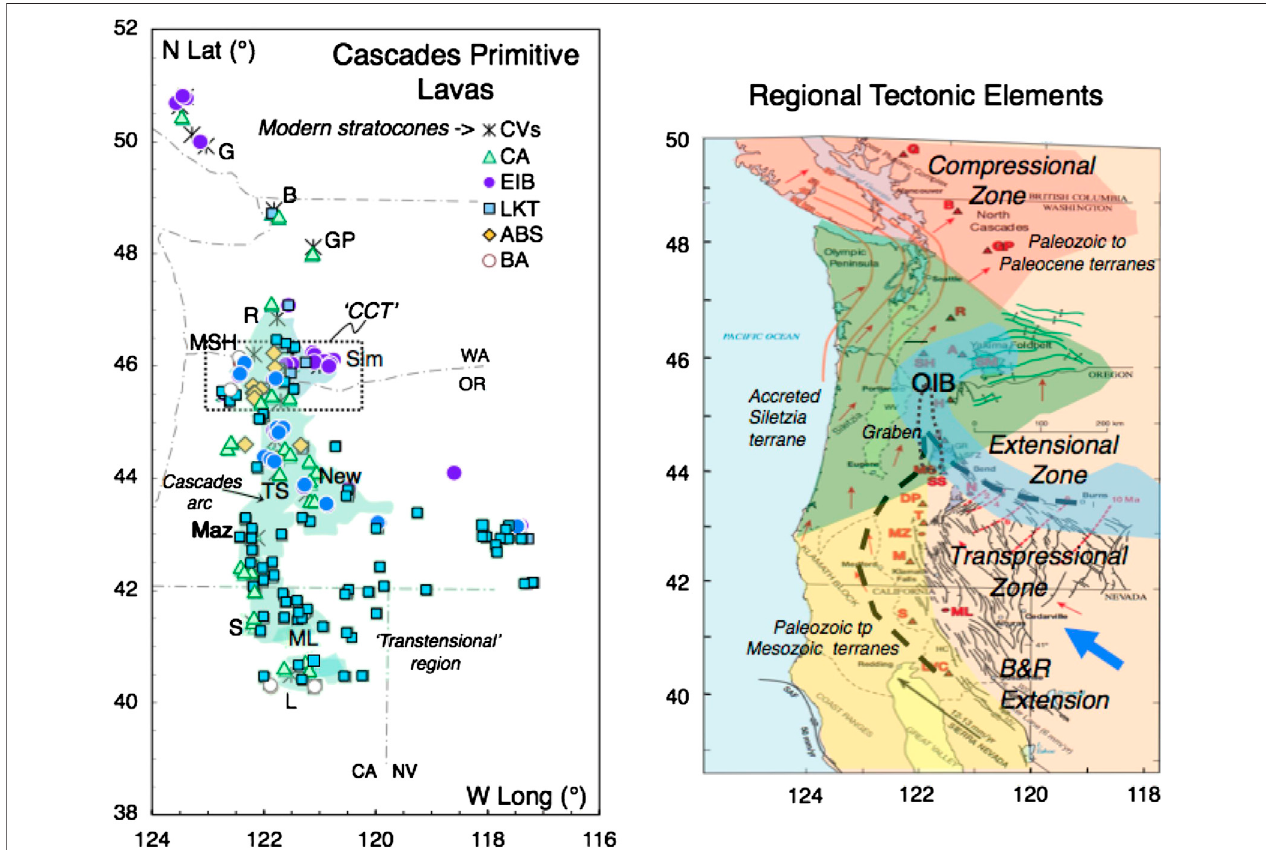
FIGURE 12 | (Left) Map showing locations of primitive Cascades basaltic lavas, with symbols denoting magma type. Only samples with Mg# > 60 and MgO > 7.5 wt%areplotted.Additionalstratoconesidenti fi edincludeMts.Garibaldi(G),Mazama(Maz)andtheThreeSisters(TS).ThedistributionofPliocene-RecentCascades volcanic rocks is shown in darker green shading, and a region of transtensional deformation (pale green shading) includes much of the southern Cascades as well as a broad High Lava Plains area behind the arc in southern Oregon; the distribution of LKT type basalts is concentrated in this area. (Right) Map (after Hildreth, 2007) shows tectonic elements in the Cascades and nearby areas, as well as along-strike differences in the nature of the underlying basement terranes (after Schmidt et al., 2008).These fi guresemphasizetherestricteddistributionofprimitiveOIB-likebasalts.ThoseinOregon-WashingtonareconcentratedintheCCTswathnear46 ° Nandin adiffusearrayextendingsoutheastwardfromthePortlandarea,followinganinferredtransitionzonebetweendominantlytranspressional(tothewest)andextensional(to theeast)tectonicregimes.TheircloseassociationwiththeregionoftheaccretedSiletziaterranemaynotbecoincidental.AlsonotethatthepreponderanceofLKTinthe southernportionsofthearcandbackarcregionsappearstobeassociatedwithextensionthatbeganpropagatingintotheregion(bluearrow)inlateMiocenetime(cf.Till et al.,